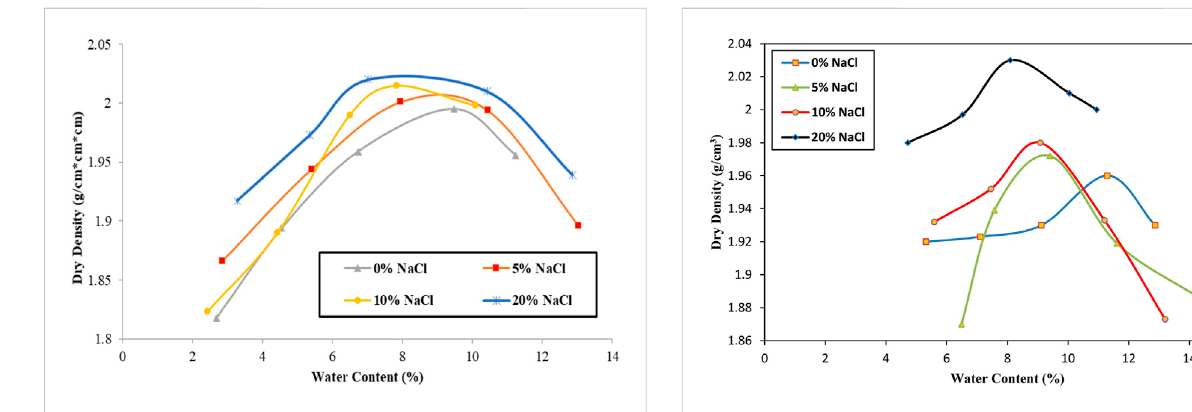
FIGURE 6 Dry density versus moisture content of different NaCl% for soil at 1.5 m depth.